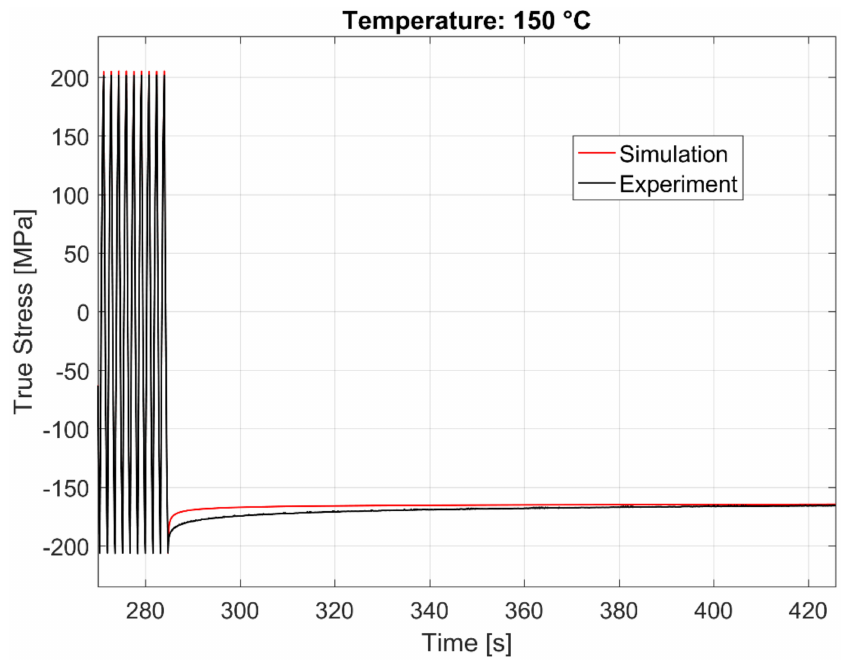
Figure 26. Time history of the experimental vs. visco-plastic model prediction at 150 ◦ C.